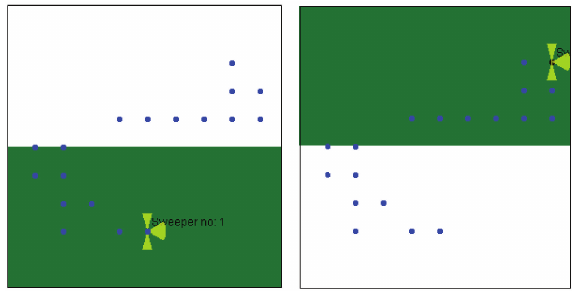
Figure 3: Two sweepers in fully random